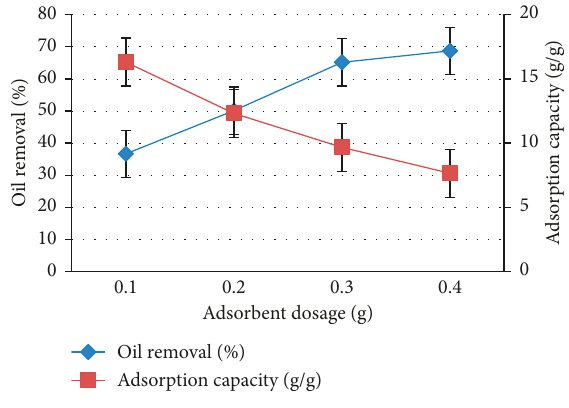
Figure 3: Effect of adsorbent